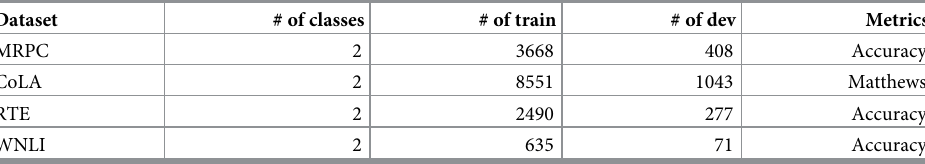
Table 1. Summary of the four GLUE datasets used in the experiments.